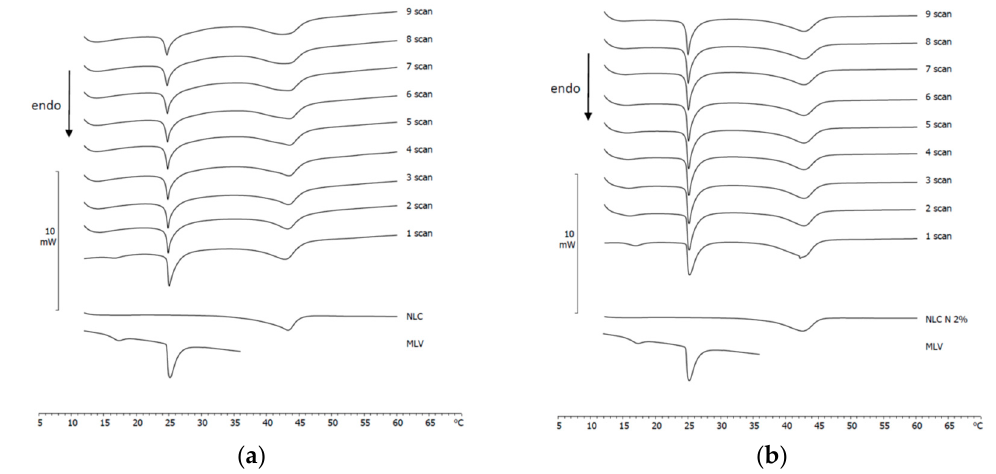
Figure 7. ( a ) Calorimetric curves, in heating mode, of MLV left in contact with unloaded NLC. The calorimetric curves are compared with the calorimetric curves of MLV and NLC. ( b ) Calorimetric curves, in heating mode, of MLV left in contact with 2% Naringein-loaded NLC. The calorimetric curves are compared with the calorimetric curves of MLV and 2% Naringenin-loaded